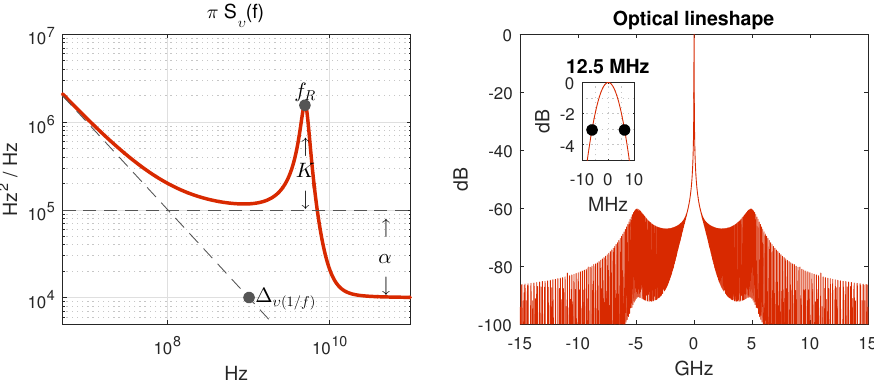
Figure 1. Left : Frequency noise power spectral density (PSD) for ∆ υ ( 1/ f ) = 10 kHz, ∆ υ int = 100 kHz, f R = 5 GHz, K = 0.3 ns and α = 3. Right : Optical spectrum calculated from Equation (2).